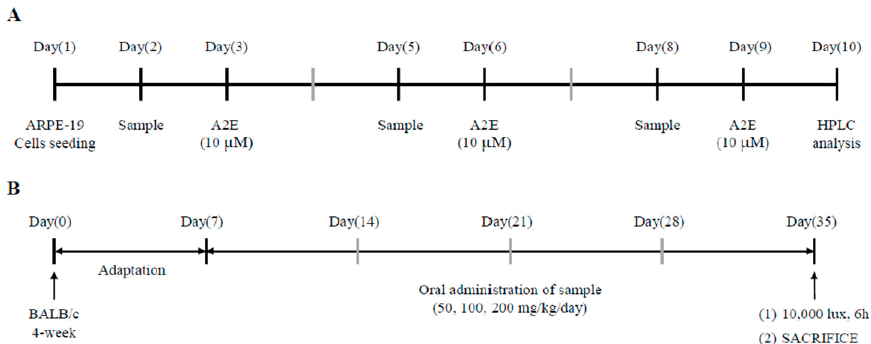
Figure 6. Scheme of treatment schedule. ( A ) Schedule for the inhibitory effect of ALE on A2E accumulation in ARPE-19 cells. ( B ) Schedule for rodent